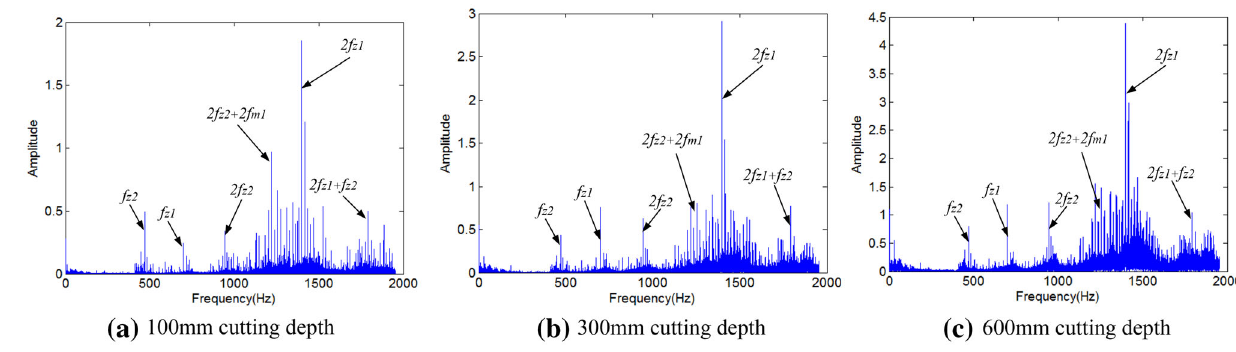
Fig. 13 Frequency coupling of spur